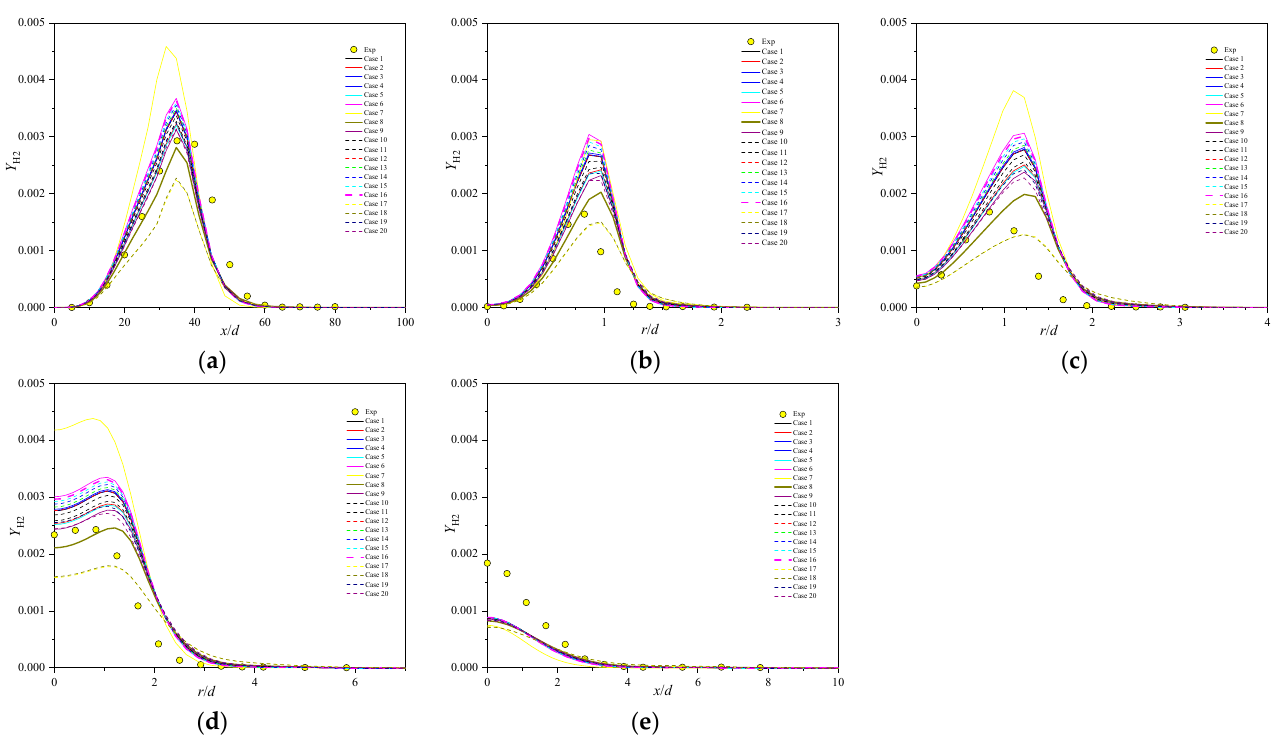
Figure 12. Comparison of measured [22,24] and predicted mean H 2 mass fraction profiles for the Sandia Flame D with 20 combinations of the primary EDC constants C D1 and C D2 . ( a ) @axis. ( b ) @ x / d = 7.5. ( c ) @ x / d = 15. ( d ) @ x / d = 30. ( e ) @ x / d =